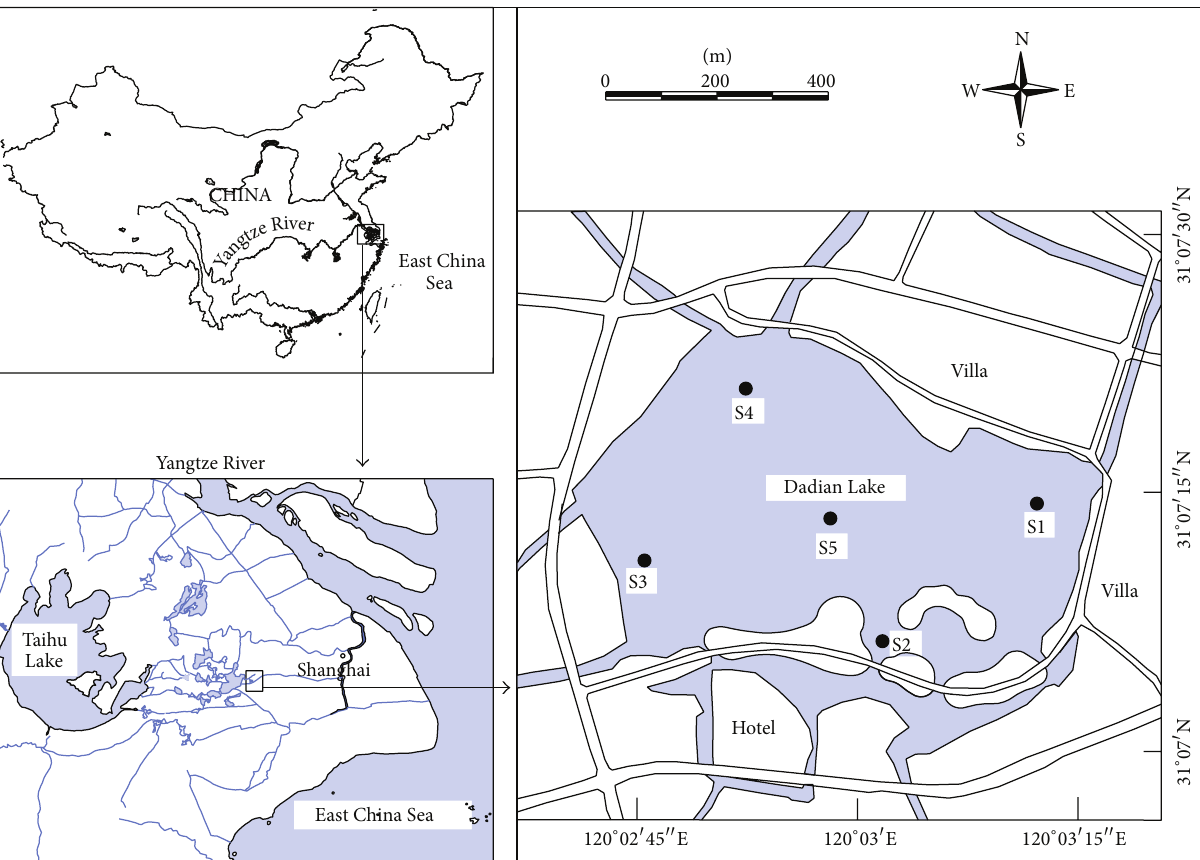
Figure 1: Location of Dadian Lake, China, and the sampling